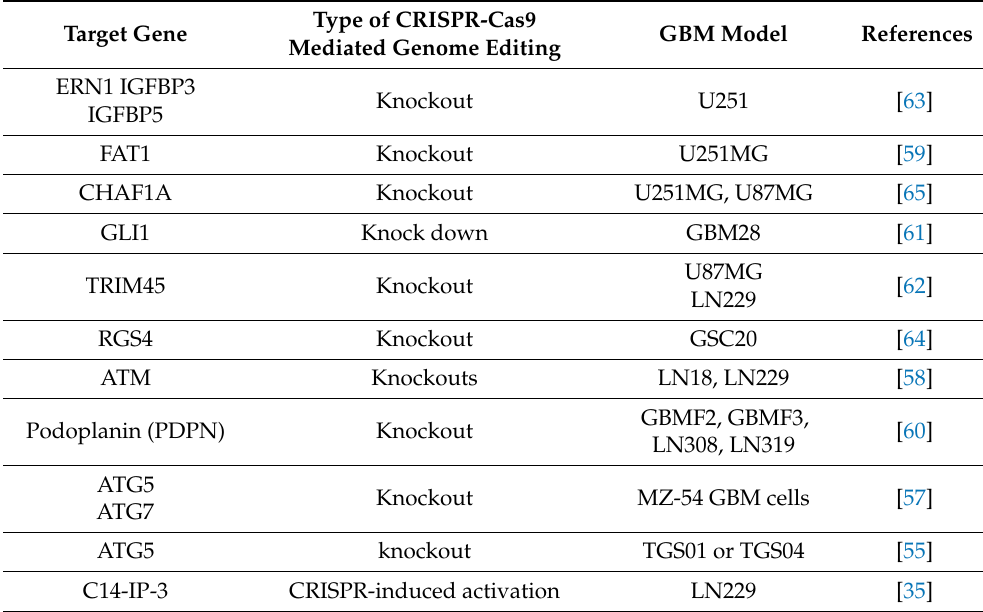
Table 3. CRISPR-Cas9 mediated gene editing of apoptosis genes in GBM.